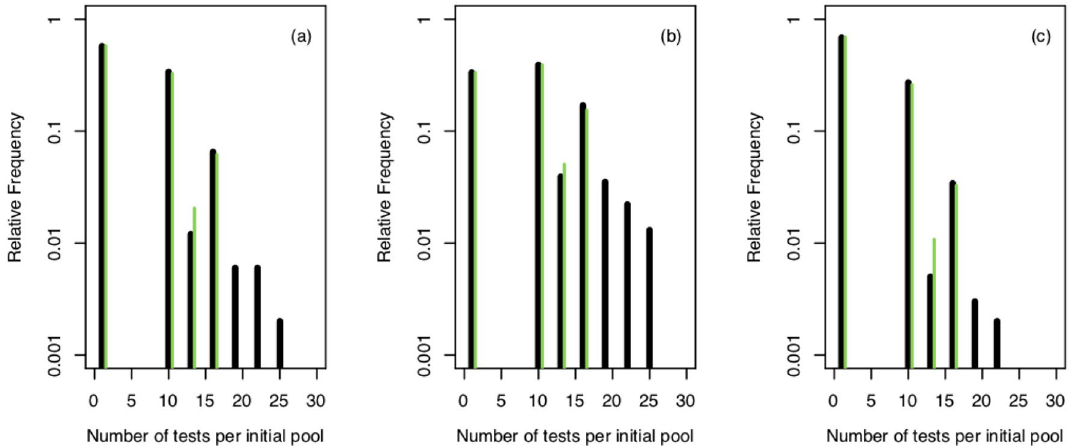
3 and m ( 3 3 , 3 2 , 3 ) applied to 1000 first-stage Figure 3. Stochastic simulations of the nested strategy with k = = pools with infection probabilities, p , for which the strategy is optimal (the one in ( b ), slightly smaller than the 2 to having k 3 and the one in ( c ), slightly larger than value at which the optimum switches from having k = = 3 to having k 4 ). The figures show histograms the value at which the optimum switches from having k = = 0.02 (544 (as fraction of occurrences and in log scale) of the number of tests performed per pool. ( a ) p = 0.0201 ) ( b ) p 0.0398 (1073 infected samples, prevalence p 0.0201 ) ( c ) infected samples, prevalence p = = = 0.0135 (369 infected samples, prevalence p 0.0201 ). Green bars correspond to the theoretical values that p = = we computed (see Supplementary Note). The apparent mismatch between theory and simulations is solely due to fluctuations and disappears as the number of initial pools is increased.